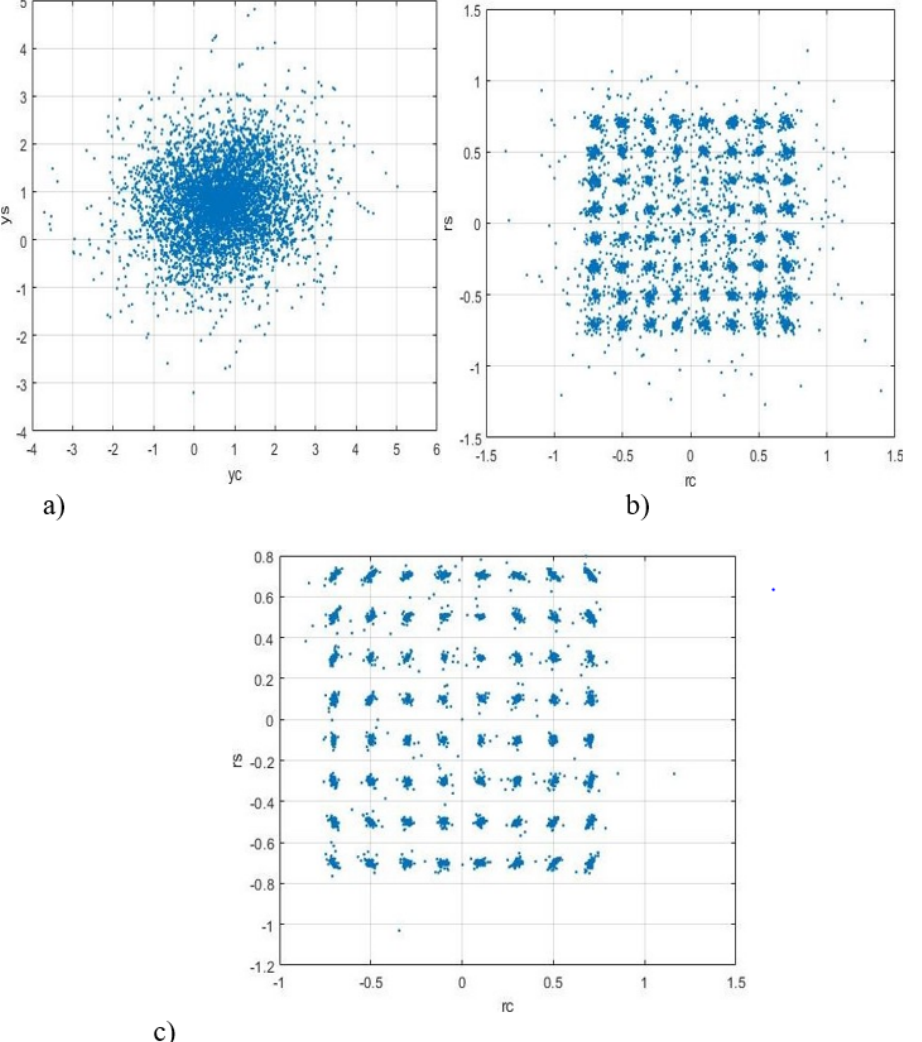
Figure 9. Constellations of the 64-QAM (SNR is 26 dB per bit) at the input of the compensator—( a ); at the output of the compensator which uses the algorithms, described by Equations (5)–(9) and (12) with p = 0, m = 10, n 1 = 100, K 0 = 1—( b ); p = 1, m = 50, n 1 = 20, K 0 = 1—( c ).